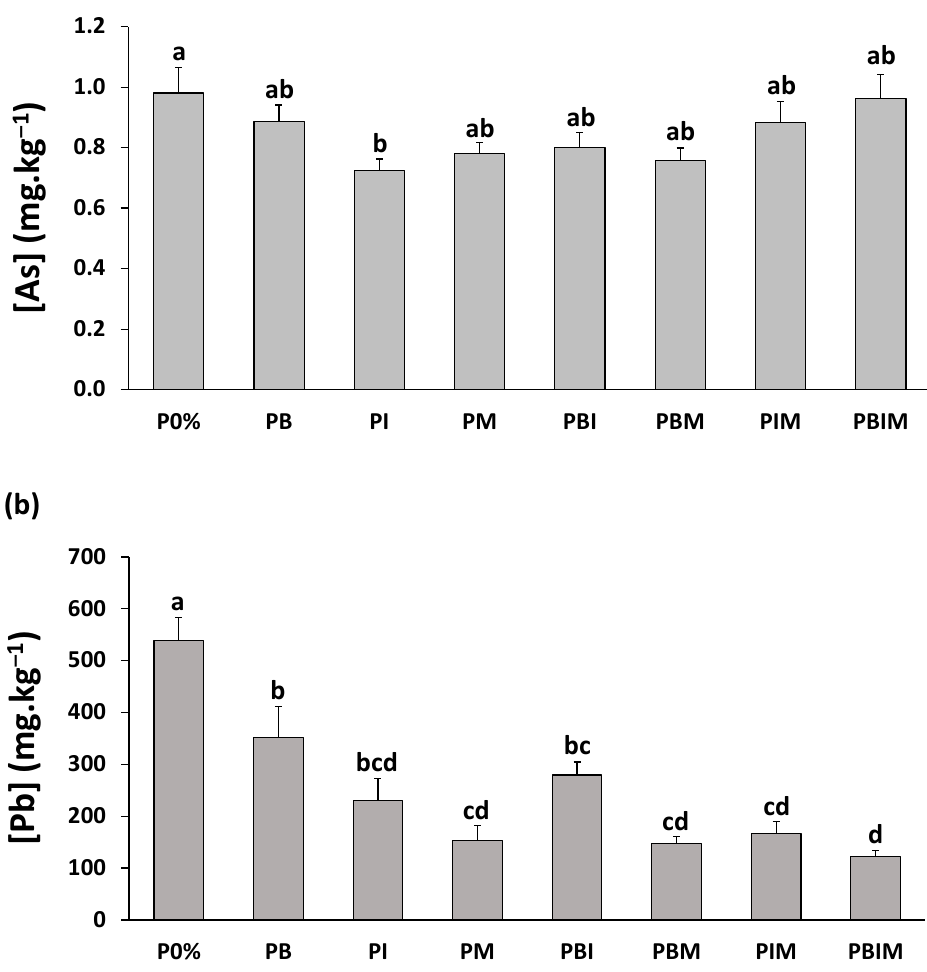
Figure 1. Soil phytoavailable arsenic ( a ) and lead ( b ) concentration (mg·kg − 1 ) determined after 60 days of Salix triandra growth (T60) in the eight studied treatments. Different letters indicate significant difference among the treatments ( p < 0.05) ( n = 5). The letter “a” is used for the highest value found. Different treatments with at least one letter in common show no significant difference.